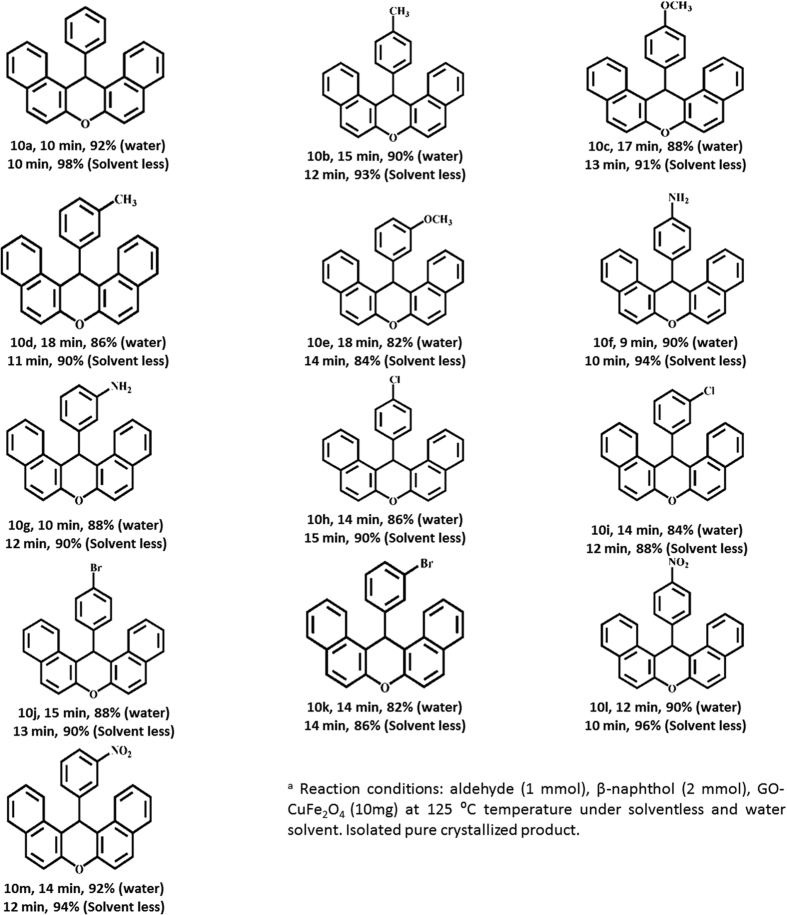
The one-pot synthesis of 14-aryl -14H-dibenzo-[a. j] xanthenes using GO-CuFe2O4 nanocompositea.